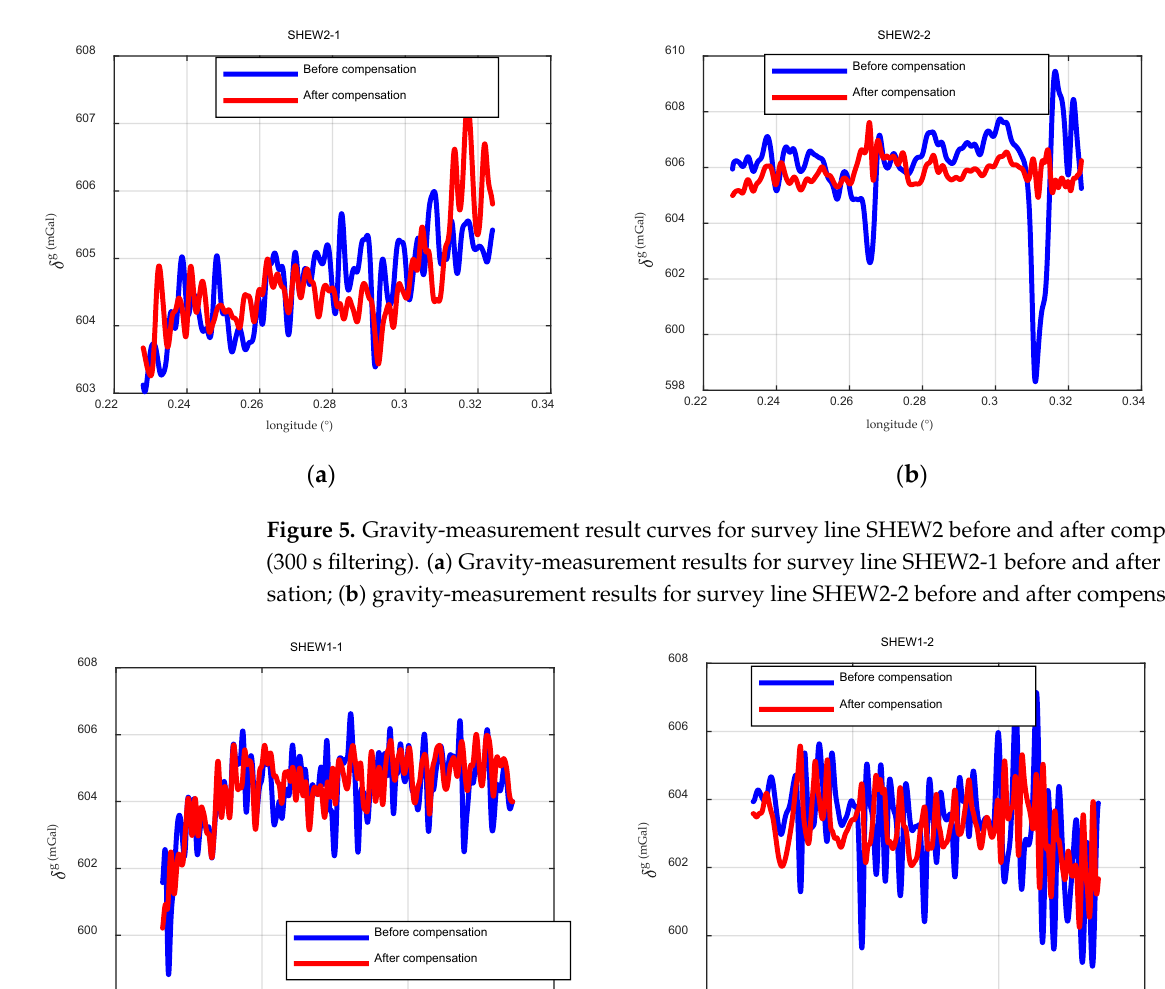
7 of 10 Table 1. Statistics of error fitting parameters. Parameter